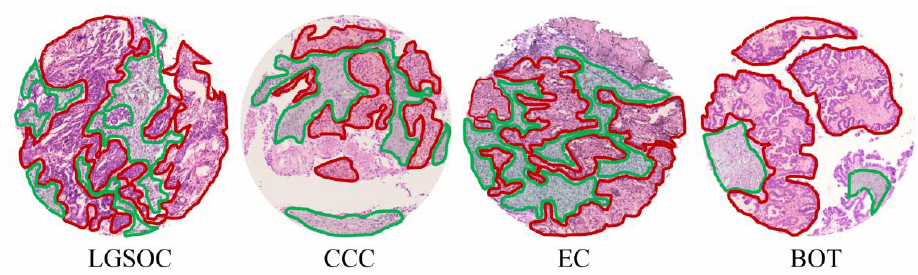
Figure 4. H&E stains of exemplary TMA cores investigated in this study. Tumor regions are marked in red, whereas tumor-stroma is marked in